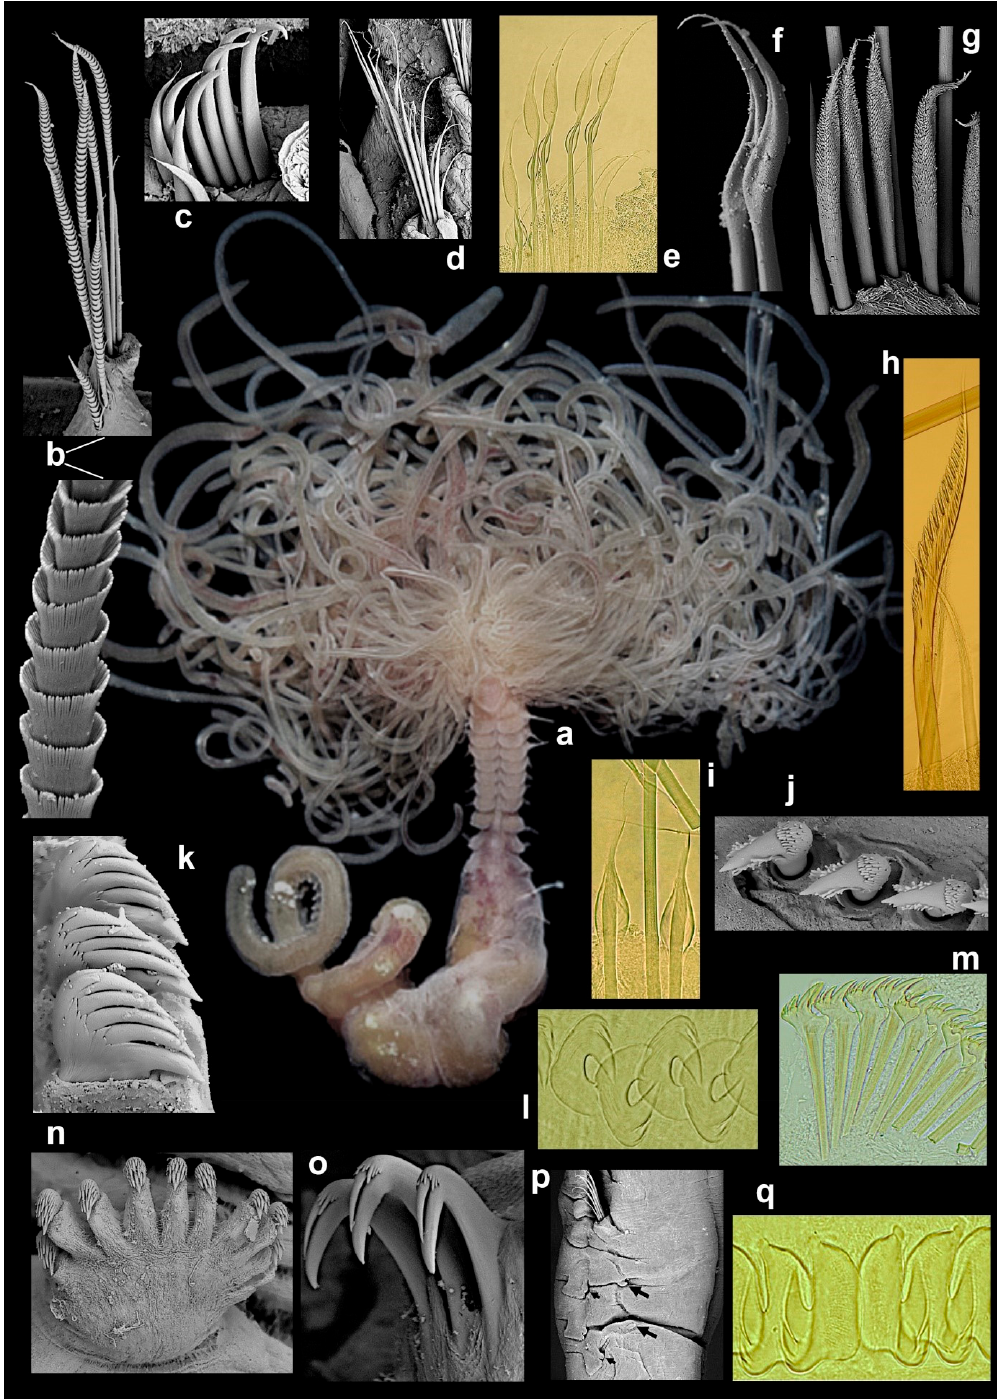
Figure 6. Diagnostic characters of terebelliforms: ( a ) Polycirrus changbunker (ZUEC 21354) (PO): entire worm, ventral view; ( b , o ) Polycirrus papillatus (PO): notochaetae, of two magnifications, and abdominal uncini, respectively (SEM); ( c , d ) Amphicteis dalmatica (AM): paleae and notochaetae of anterior segment, respectively; ( e ) Spinosphaera barega (TER): posterior thoracic notochaetae; ( f ) Pista anneae (TER): notochaetae, segment X; ( g ) Pistella franciscana (TER): notochaetae, segment VIII; ( h ) Alvinella pompejana (AL): notochaetae, anterior segment; ( i ) Leaena ebranchiata (TER): notochaetae of anterior row, anterior segment; ( j ) Trichobranchus hirsutus (TR): uncini, segment VI (SEM); ( k ) Loimia pseudotriloba (TER): abdominal uncini (SEM); ( l ) Nicolea vaili ( TER ) : uncini, segment 10; ( m ) Lanicides rubra (TER): uncini, segment 5; ( n ) Trichobranchus hirsutus (TR ) : neuropodium, segment XXI; ( p ) Amphicteis dalmatica (AM): last thoracic and first two abdominal segments; large arrows point to abdominal rudimental notopodia, short arrows point to neuropodial dorsal papillae; ( q ) Thelepus paiderotos (TH): uncini, segment VII.